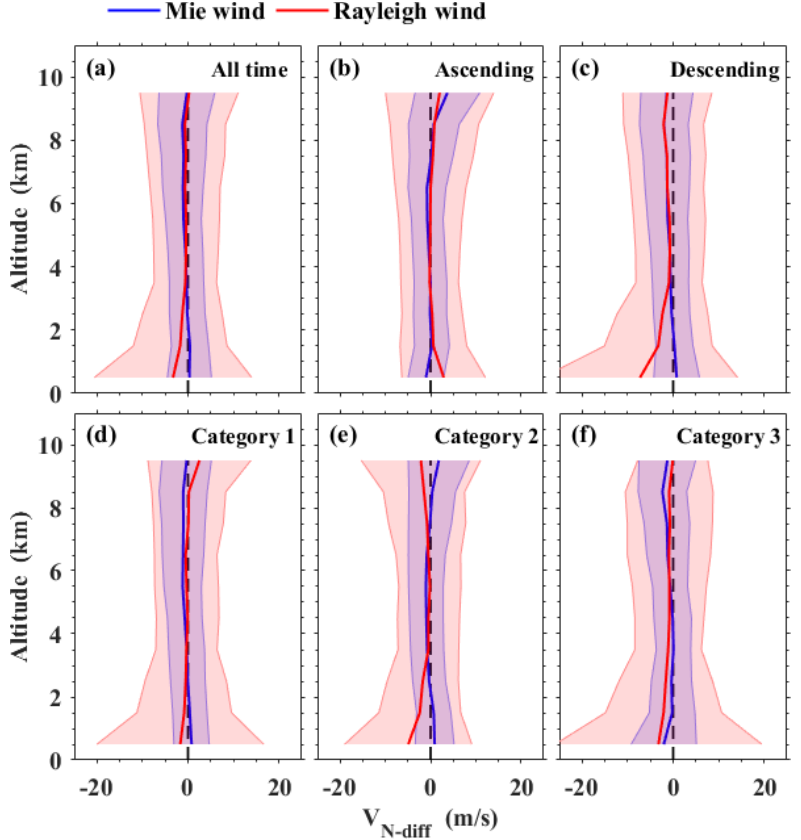
Figure 11. Vertical distributions of the normalized differences between the Aeolus HLOS and RWP HLOS wind speeds for (a) all time, (b) ascending orbits, (c) descending orbits, (d) category 1, (e) category 2, and (f) category 3. Blue and red lines represent Mie-cloudy and Rayleigh-clear wind, respectively. Corresponding color-shaded areas represent 1 standard deviation to each side of the mean normalized difference.